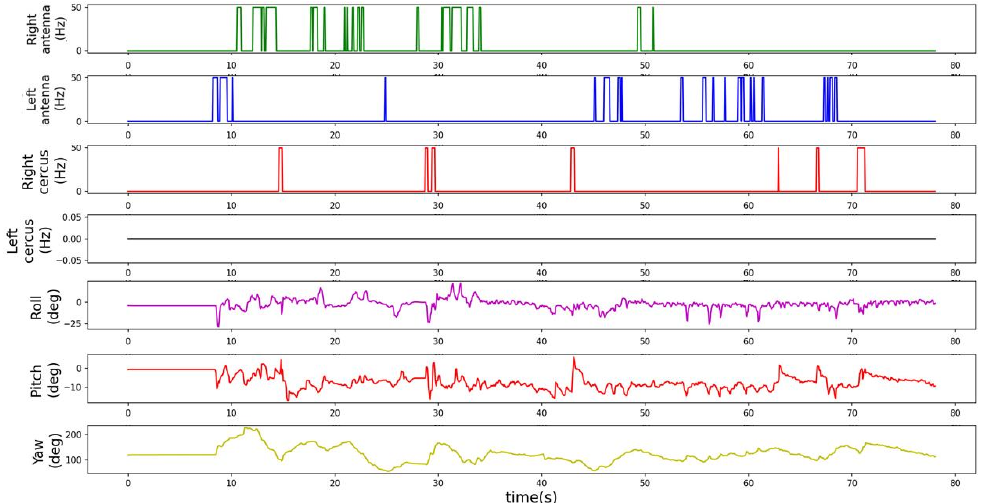
Figure 11. Cockroach attitude angle response for path following trajectory commanded from Bang- ladesh.